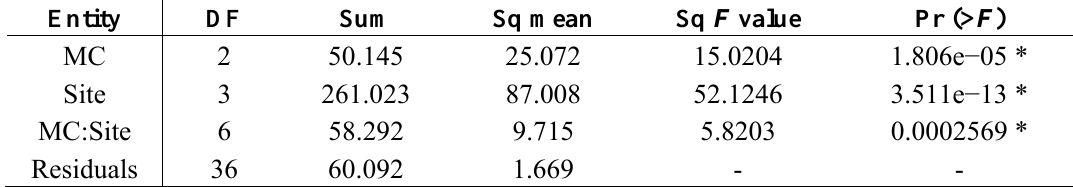
Table 3. Analysis of covariance (ANCOVA) statistical results indicating the effect of interaction between sites and MC congener on MC